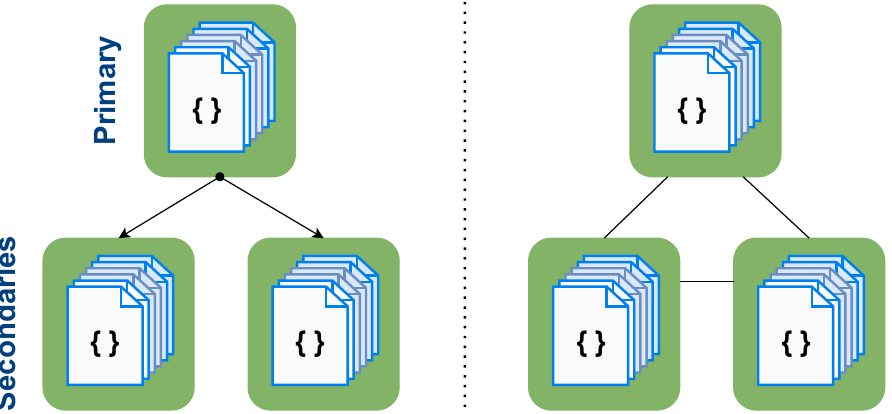
Figure 4. Replication sample: on the left, under a CP approximation of the CAP theorem; on the right, under an AP